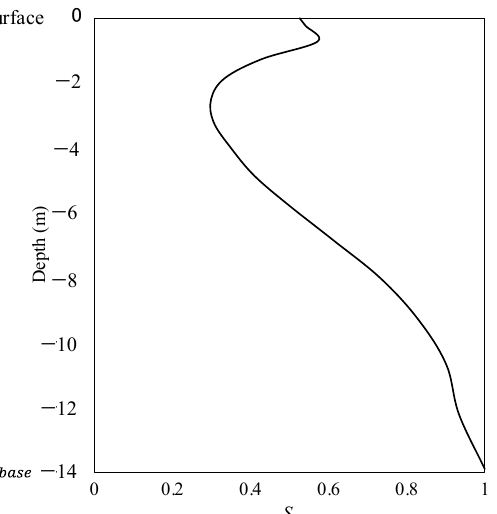
Figure 6. The normalized relative saturation ( S r ) variation with depth from the PT06 during the April survey.